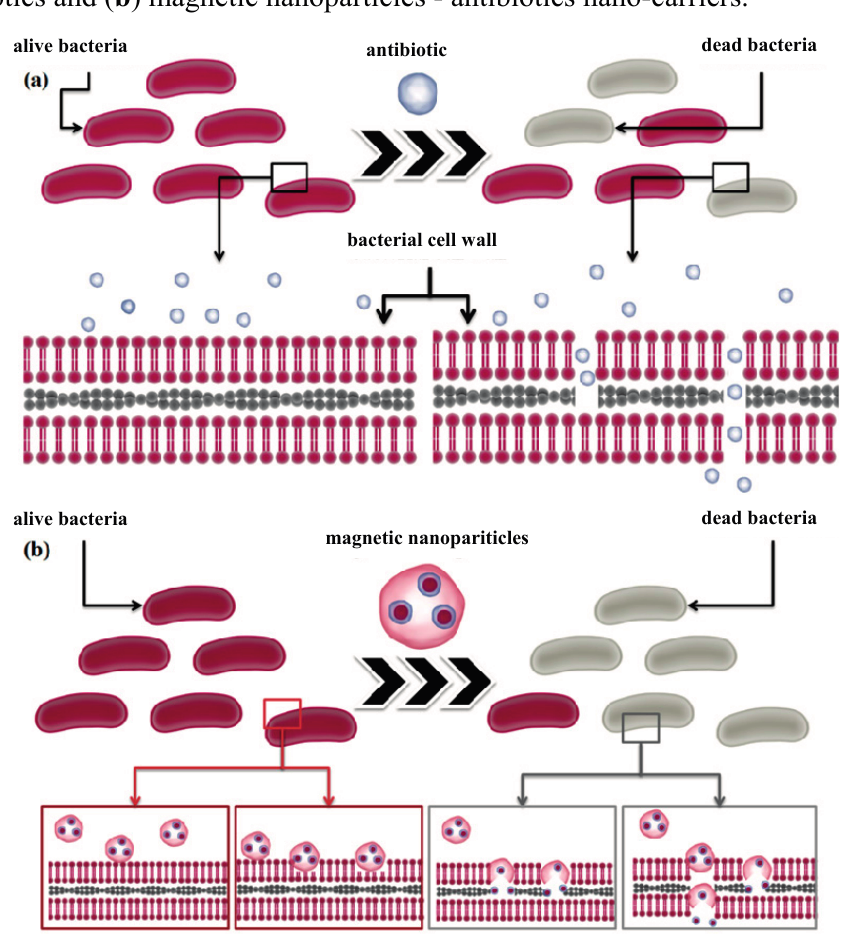
Figure 3. Schematic representation of the possible interaction between bacteria with ( a ) antibiotics and ( b ) magnetic nanoparticles - antibiotics